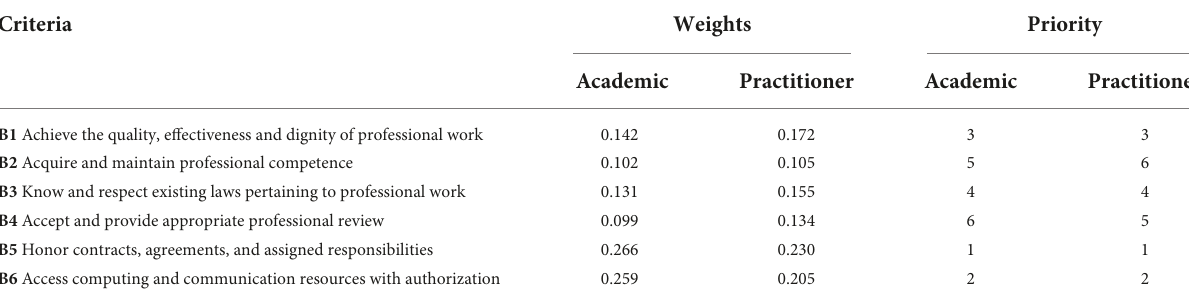
TABLE 10 Weights and ranking of organizational/workplace responsibilities criteria by IT experts.